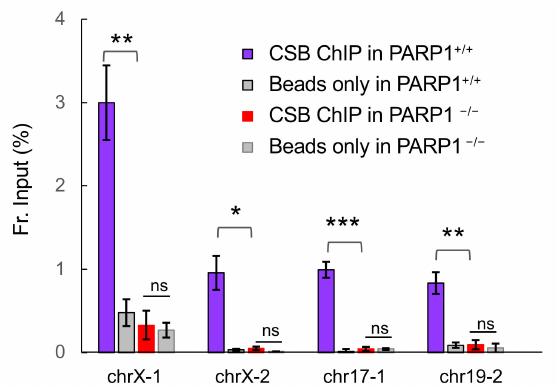
Figure 1. PARP1 is essential for the recruitment of CSB to the top four oxidative stress-induced CSB occupancy sites. CSB ChIP-qPCR was carried out in PARP1 +/+ and PARP1 − / − RPE cells after a 1 h, 100 µ M menadione treatment. Shown is CSB enrichment at the top four menadione-induced CSB binding sites, using primers within the peak binding regions [17]. Data are presented as means +/ − SEM ( n = 3 biological replicates). Paired t -tests were used to compare CSB enrichment between cells with and without PARP1; *: p < 0.05, **: p < 0.01, ***: p <